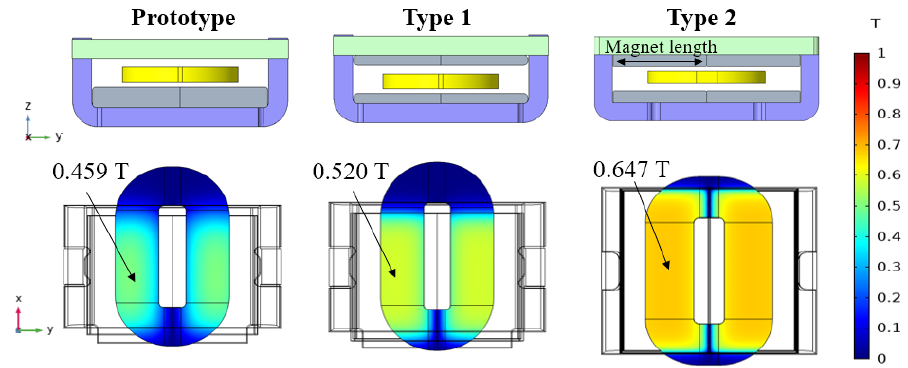
Figure 6. Model and flux density distribution comparison.